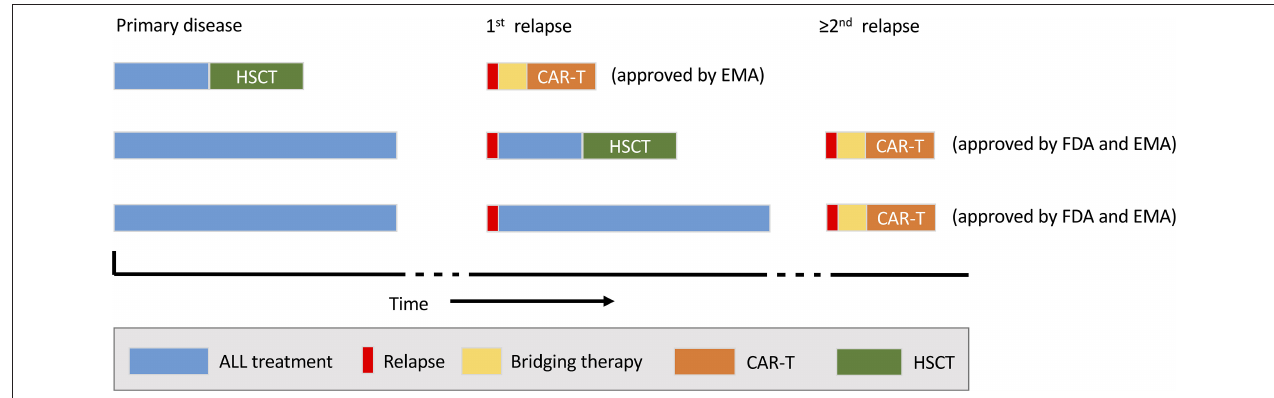
FIGURE 2 | Current indications for commercial chimeric antigen receptor (CAR) T-cell therapy (tisagenlecleucel). The possible timing of CAR-T (orange) within the treatment sequence for acute lymphoblast leukaemia (ALL) and relative to haematopoietic stem cell transplantation (HSCT; blue) is shown. EMA, European Medicines Agency; FDA, US Food and Drug